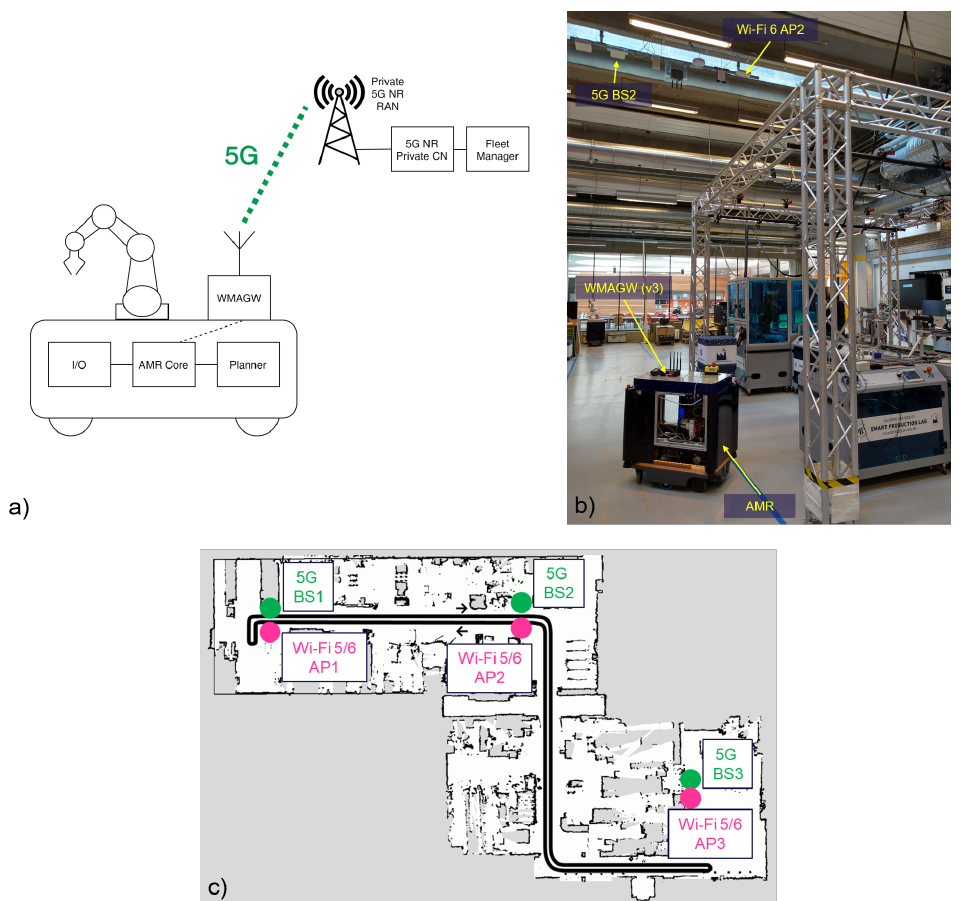
Figure 9. ( a ) Architecture of the 5G-integrated AMR solution including the AMR, WMAGW, 5G network infrastructure and AMR fleet manager controller. ( b ) Picture of the 5G-integrated AMR solu- tion deployed at the lab for the performance testing over the private 5G network and benchmarking with Wi-Fi 6. ( c ) Lab plan overview including the location of the 5G base stations and Wi-Fi 6 access points, as well as the measurement route followed to test the performance of the AMR in realistic mobility conditions.